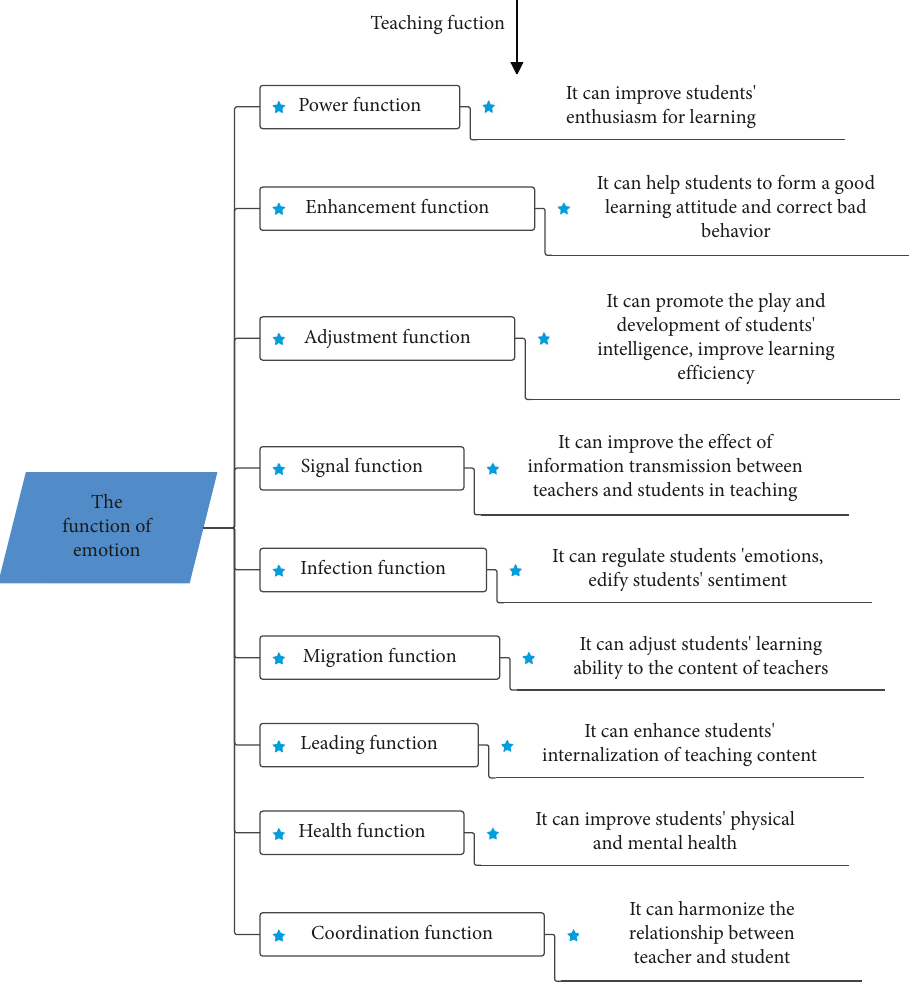
Figure 6: Emotional English teaching